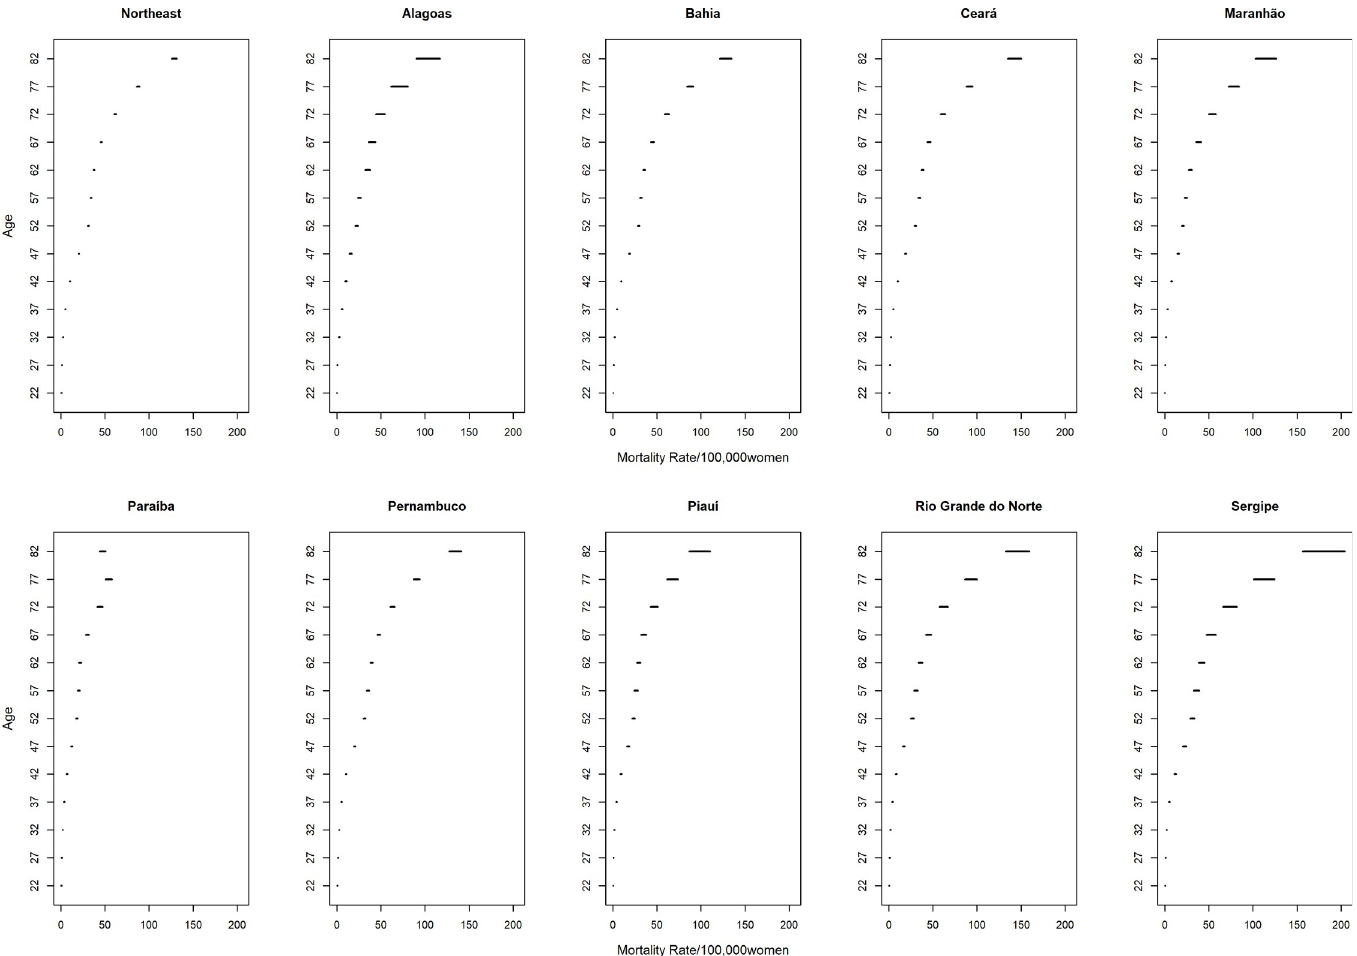
Fig 7. Results of the age-period-cohort model adjusted for breast cancer mortality according to the age effect and states of the Northeast, Brazil, 1980–2019.